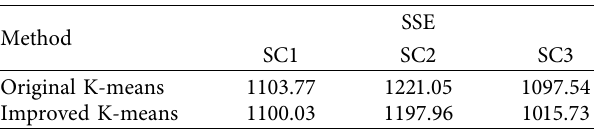
Table 5: Comparison of the results of our proposed approach with other relevant literature